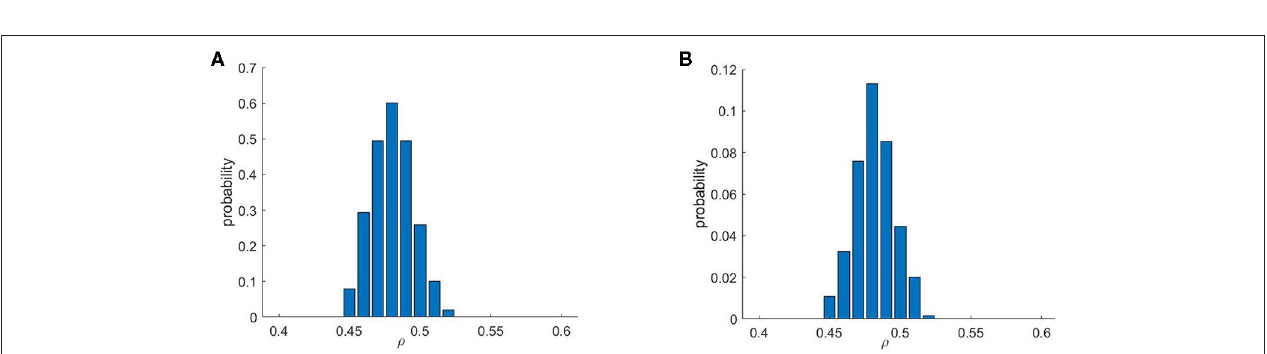
FIGURE 4 | Re-entry formation depends critically on the amount of fibrotic obstructions. Only a specific range of values of ρ , the probability that any individual mesh element is obstructed, permits re-entry formation. Shown are the probabilities that a given fibrotic realisation produced a re-entry for (A) at least one stimulus scenario and (B) for an individual stimulus scenario. A comparison of these two histograms highlights the importance of considering multiple stimulus locations when evaluating a structure for potential as an arrhythmic substrate.